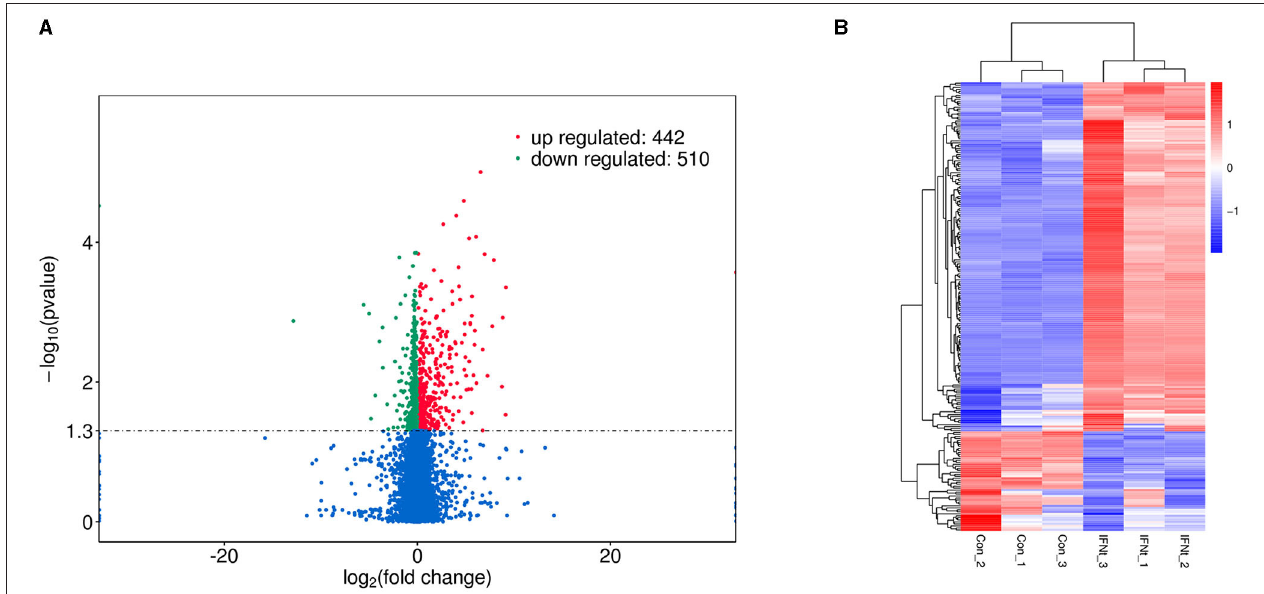
FIGURE 1 | Volcano plot and heatmap of DEGs in IFNT-treated gEECs. ( A) Volcano plot. Genes were plotted in green for downregulation and red for upregulation, and non-significant genes are shown as blue points. (B) Heatmap. Log 10 (FPKM + 1) was used for clustering, red for high expression genes, and blue for low expression